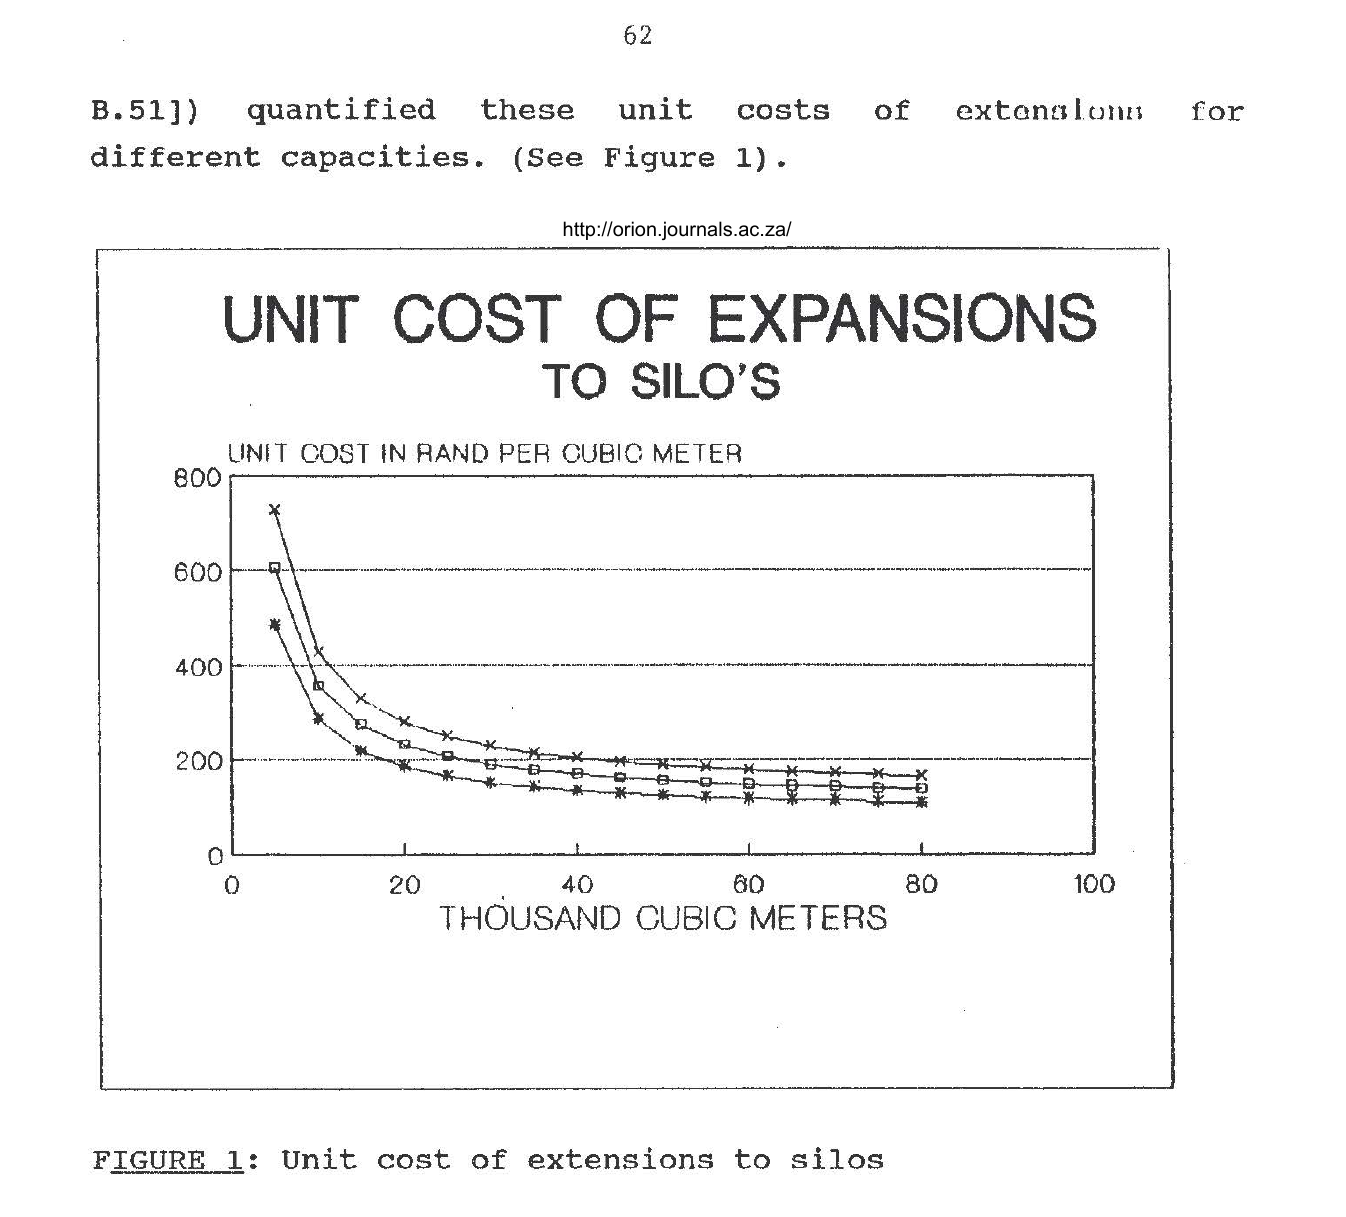
FIGURE 1: Unit cost of extensions to